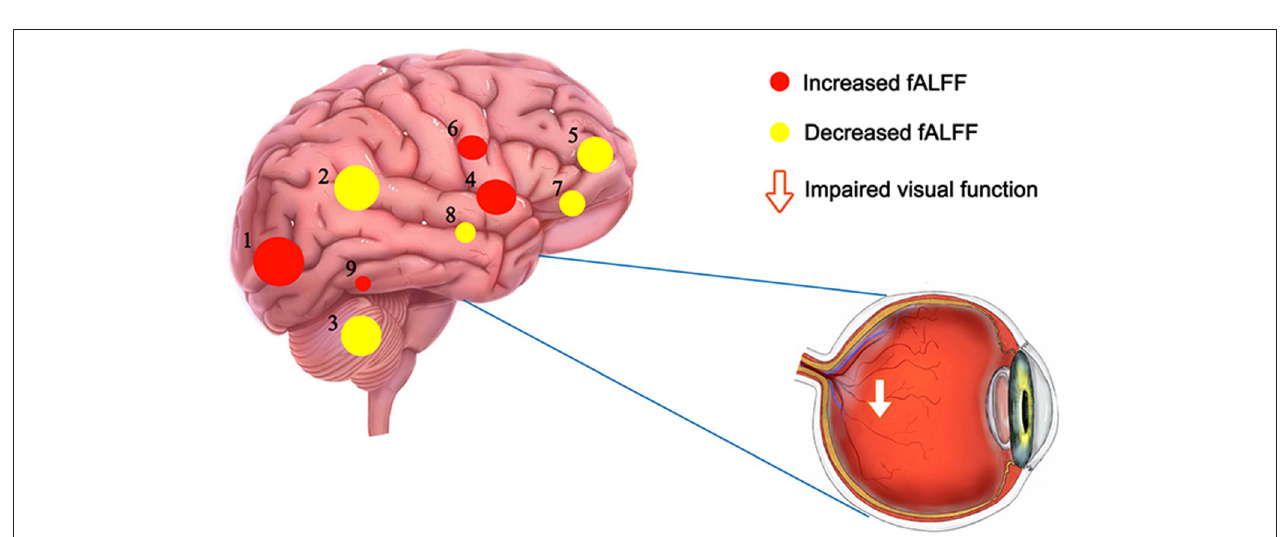
FIGURE 4 | The fALFF results of brain activity in the PAT group. Compared with the HCs, the fALFF of the following regions were increased to various extents: 1-left middle occipital gyrus (t = 4.9), 4-right globus pallidum (t = 4.36), 6-right anterior cingulate and paracingulate gyri (t = 4.24), 9-left lingual gyrus (t = 3.54), and decreased fALFF values in the 2-left inferior parietal gyrus (t = – 4.75), 3-right cerebellum (t = – 4.69), 5-right medial orbitofrontal gyrus (t = – 4.35), 7- left triangle inferior frontal gyrus (t = – 4.05) and 8-left fusiform gyrus (t = – 3.688). The sizes of the spots denote the degree of quantitative changes. HCs, healthy controls; fALFF, fractional amplitude of low-frequency fluctuations; PAT, MGD patient in SO population.